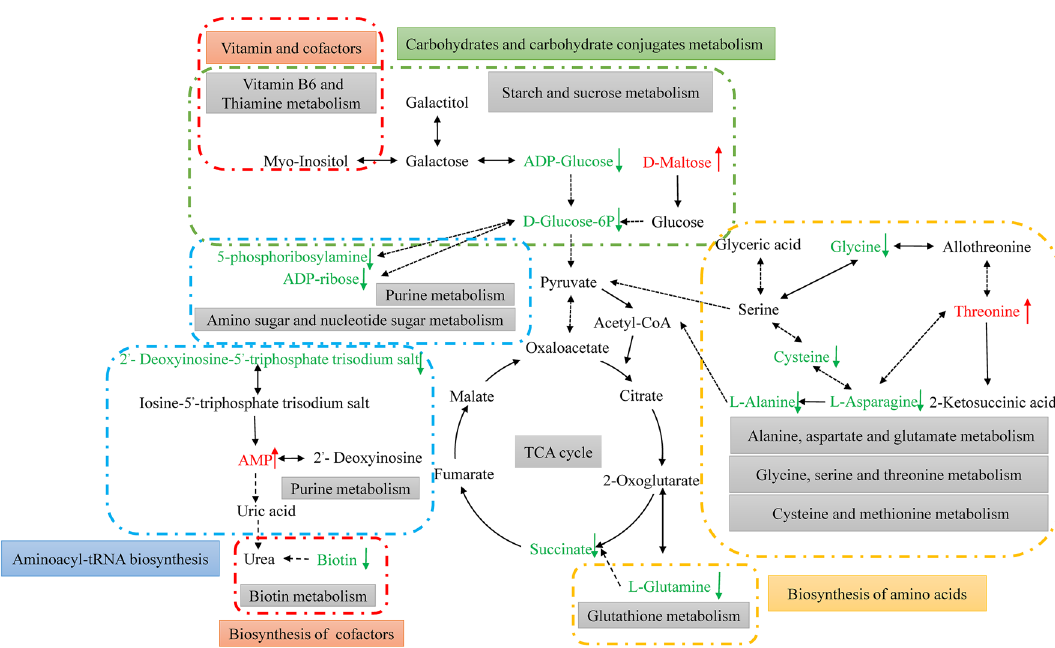
Figure 8. Schematic overview of the primarily metabolic pathways affected autotomy of siphon among S. grandis . The red characters indicated increased metabolites, and the green ones indicated decreased